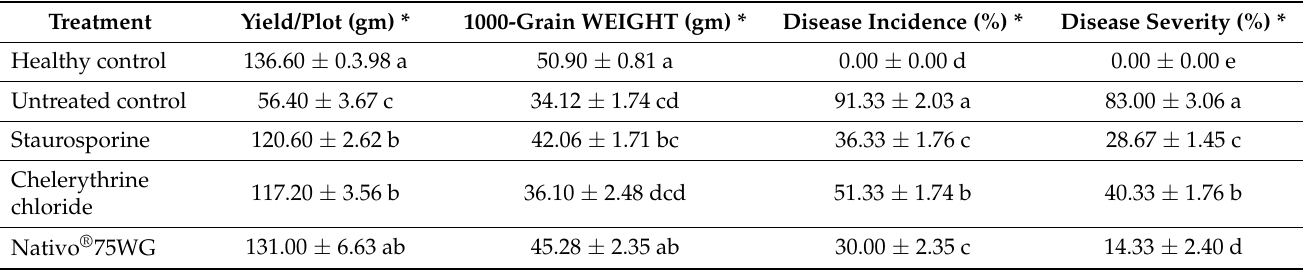
Figure 7. Suppression of wheat blast symptoms with staurosporine and chelerythrine chloride at 5 µg/mL. Herein, ( a ) Non-inoculated, non-treated spike, ( b ) Water control + MoT inoculation, ( c ) Staurosporine + MoT inoculation, ( d ) chelerythrine chloride + MoT inoculation, ( e ) Nativo ® 75WG + MoT inoculation. Table 2. Effect of staurosporine and chelerythrine chloride on Yield and Yield Components of the Wheat Variety BARI Gom-26 under Field Condition after Artificial Inoculation with Wheat Blast